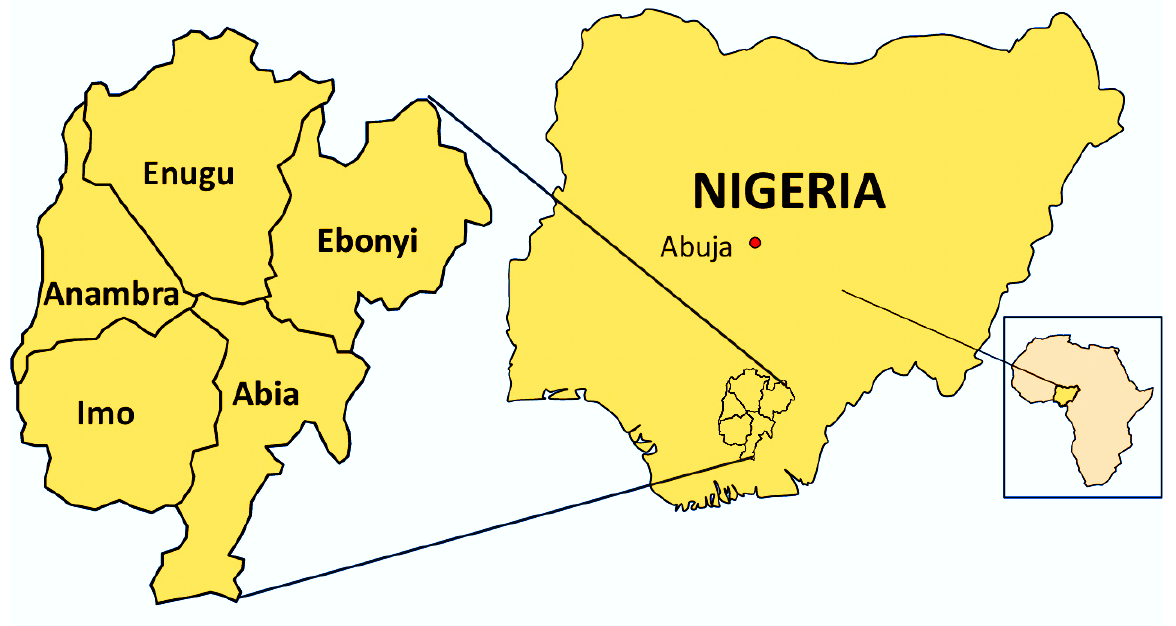
Figure 1. Map of the study area, the South-East geopolitical zone of Nigeria, showing the positions of the zone in African and Nigerian maps, and the constituent five Nigerian states that comprise the South-Eastern part.